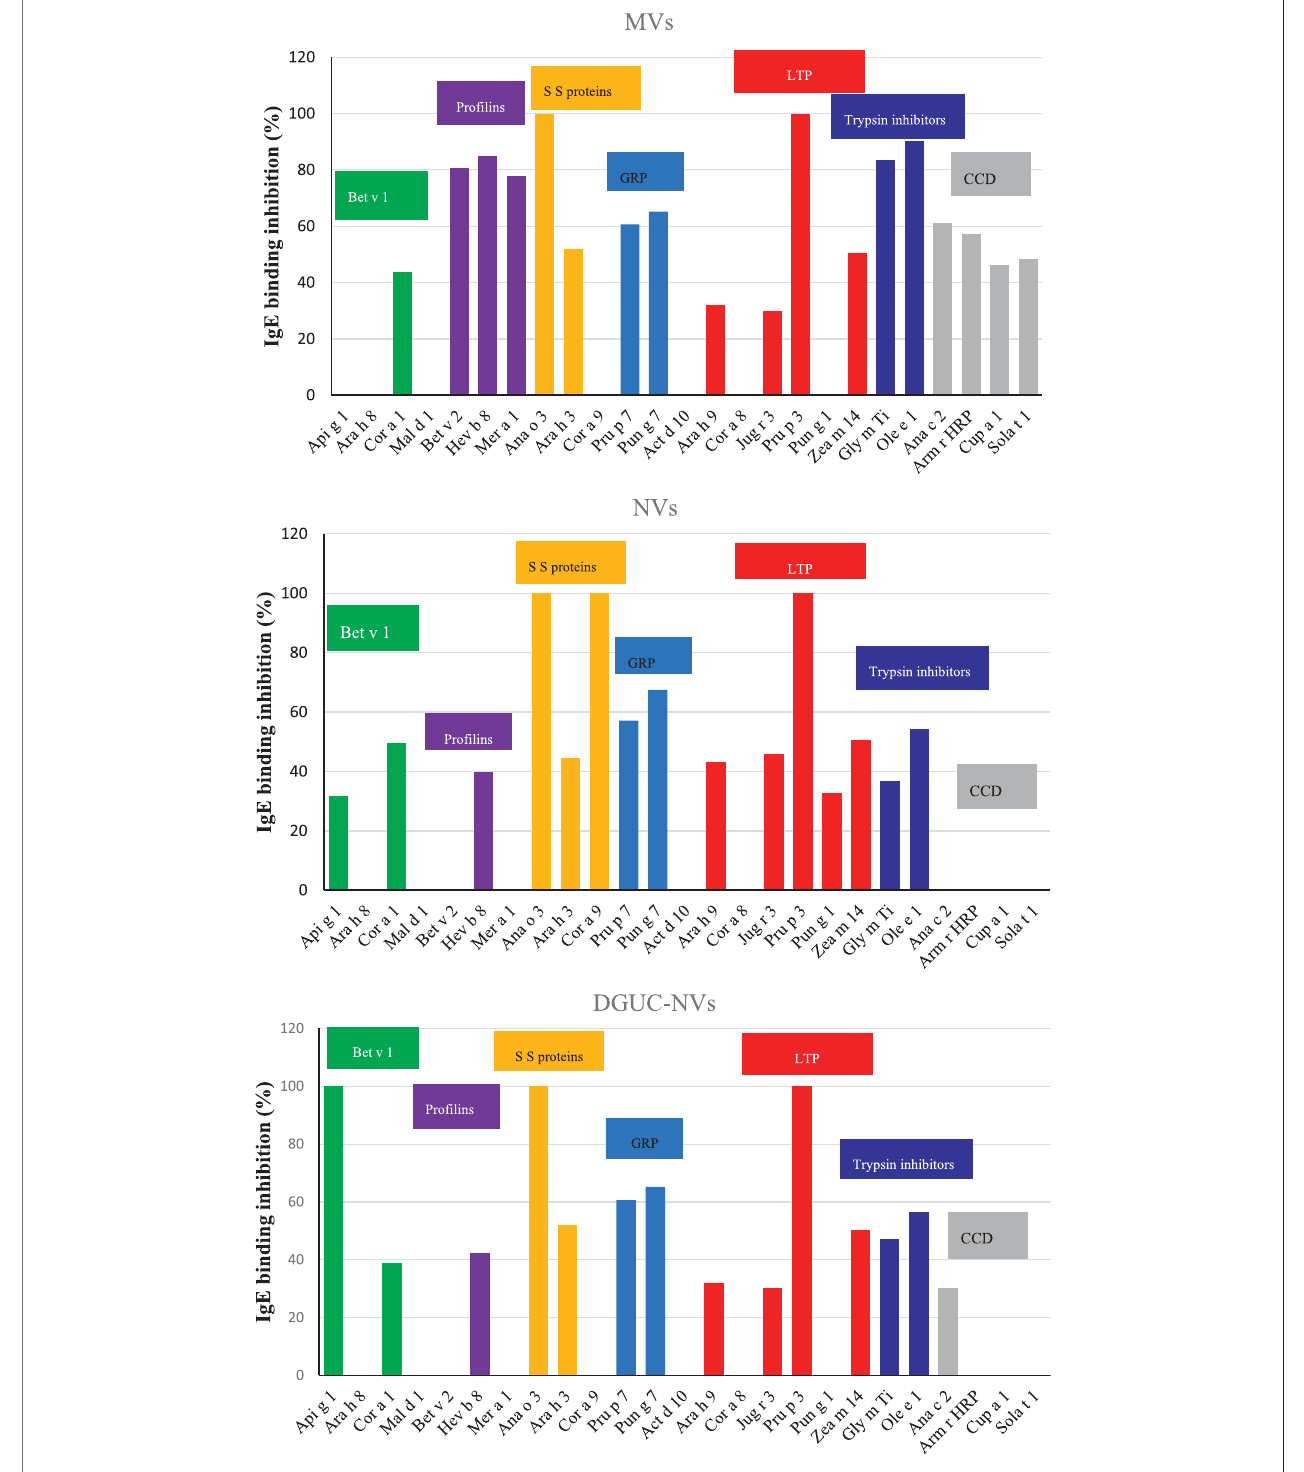
FIGURE 4 | IgE-binding inhibition assays using the FABER testing system with the SPHIAa method and a pool of sera from allergic patients as the provider of speci fi c IgE. The three panels show the percentage of inhibition on the indicated allergens using NVs, MVs, and DGUC-NVs as inhibitors. The allergens belonging to the sameprotein familyhave been grouped. The protein families are highlighted with different colors: Betv 1-like allergens in green, pro fi linsin purple, seed storage proteins in yellow, gibberellin-regulated proteins (GRP) in light blue, LTP in dark red, trypsin inhibitors in blue. In addition, cross-reactive carbohydrate determinant (CCD)- bearing proteins are highlighted in